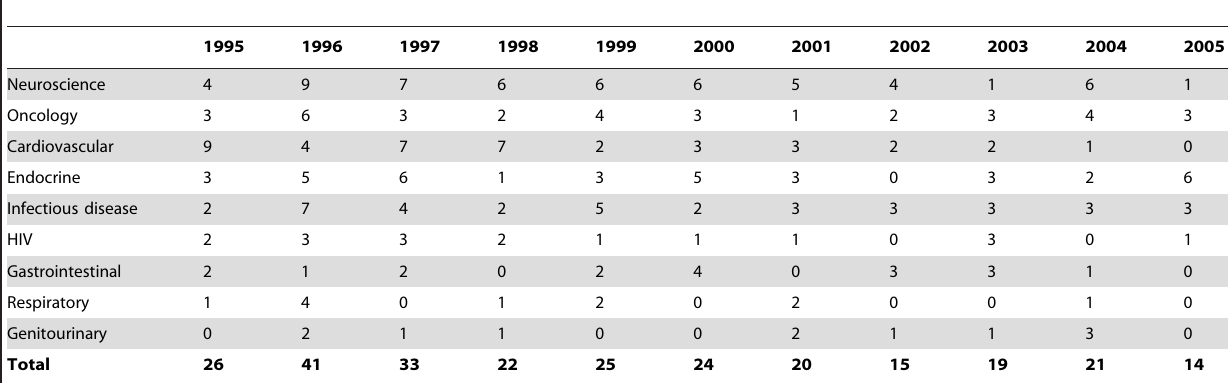
Table 3. New Molecular Entities Approved by US Food and Drug Administration by Therapeutic Area,